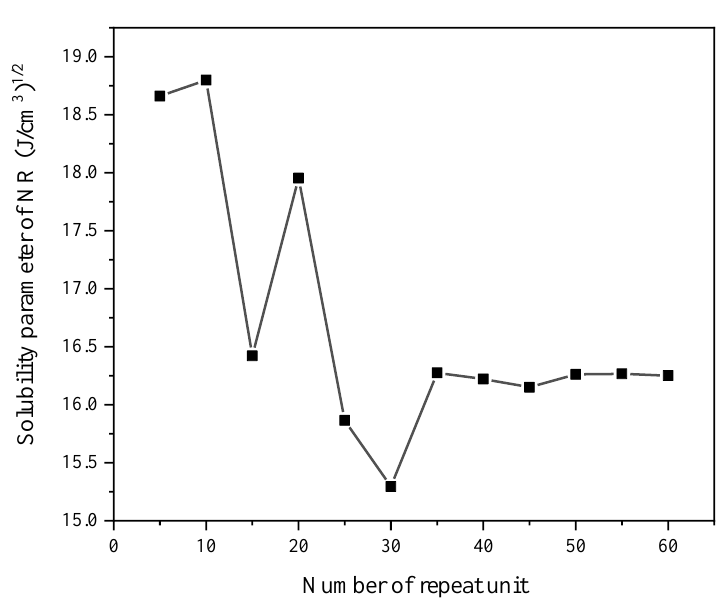
Figure 1. Solubility parameters NR with different degree of polymerization. The modelling of uncross-linked CNT/VNR is shown in Figure 2. Hydrogen atoms were added at both ends for saturated CNT to eliminate the end-side effects. The size and the corresponding positions of the CNT in different CNT content periodic cells are shown in Figure 2g. The crosslink density is defined by: